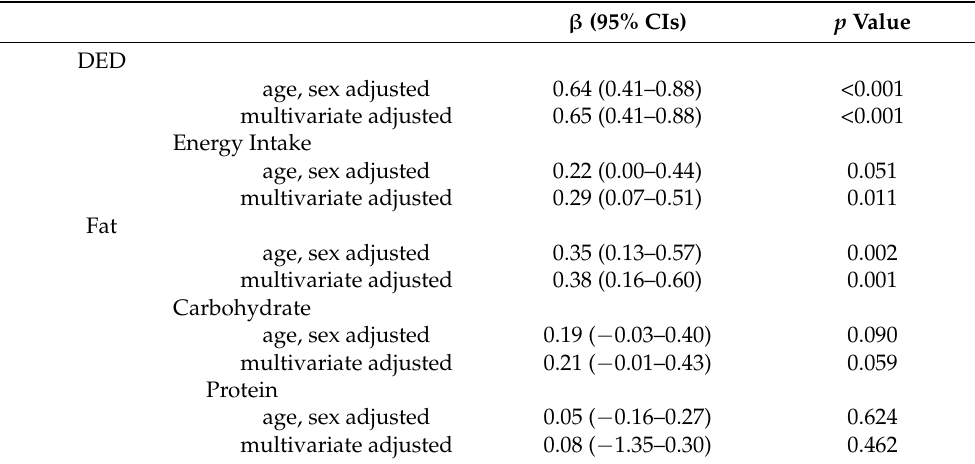
Table 3. β coefficient of BMI with per 1 SD increment according to DED, intake of energy, and macronutrients.